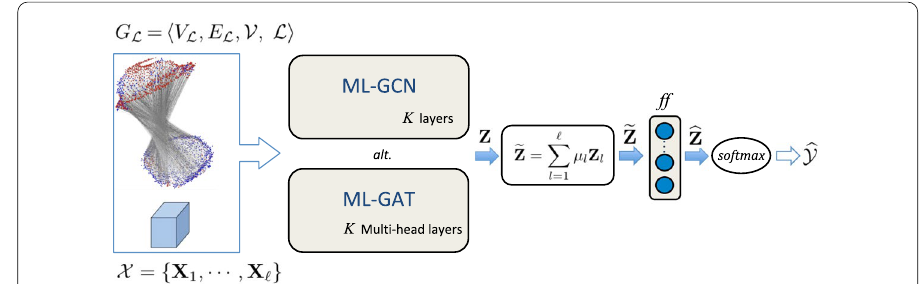
Fig. 2 Illustration of our proposed framework for node embedding generation and entity classification in a multilayer